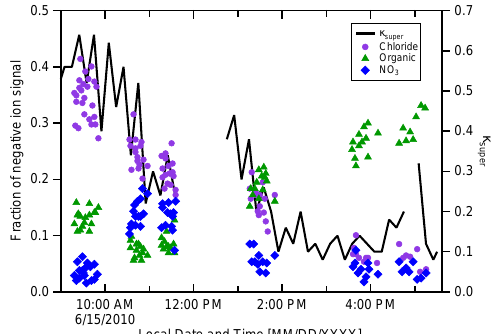
Figure 7. Fractional contributions (left axis) of chloride (purple), organics (green) and nitrates (blue) in the PALMS single particle negative ion mass spectra for sea-salt-containing particles, identi- fied by sodium in the positive ion spectra, and (right axis) the de- rived supermicron hygroscopicity parameter, κ super . The ion frac- tions do not add up to unity due to contributions from other ion peaks not included